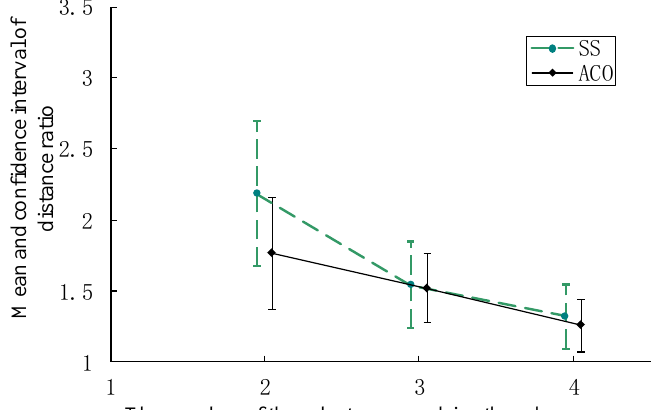
Figure 15. The mean value and confidence interval of distance ratio on condition that the first robot approached the gas